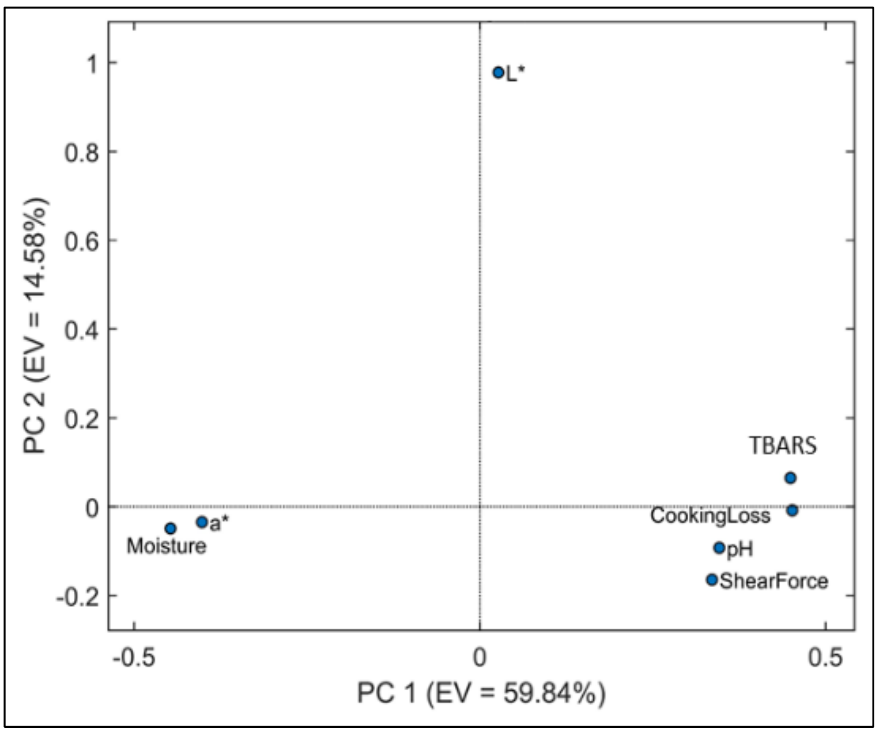
Figure 1. PC1 vs. PC2: Loading plot of physicochemical variables studied in sous vide chicken fillet breasts cooked at different combinations of temperature (60, 70, 80, and 100 °C) and time (60, 90, 120, and 150 min).